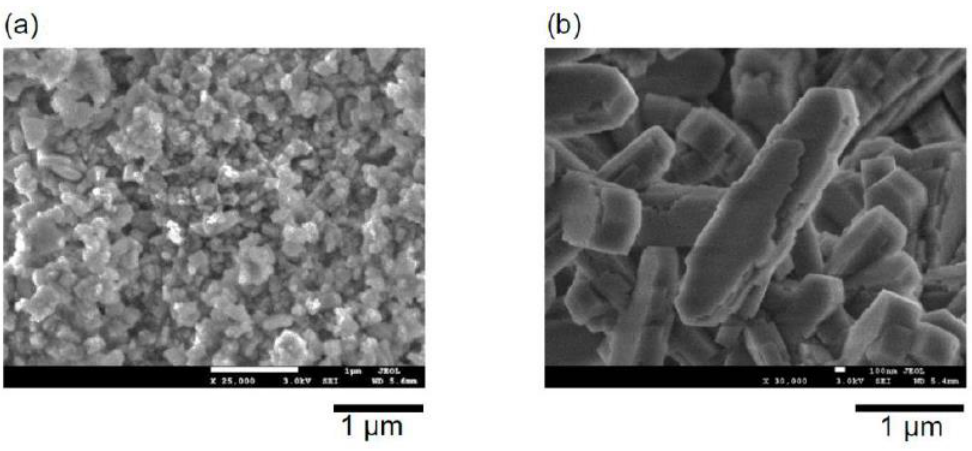
Figure 7. Field emission scanning electron microscopy images of the ( a ) MFI nano (20) and ( b ) MFI micron (20). The nomenclature for these samples is explained in Section 2.3.